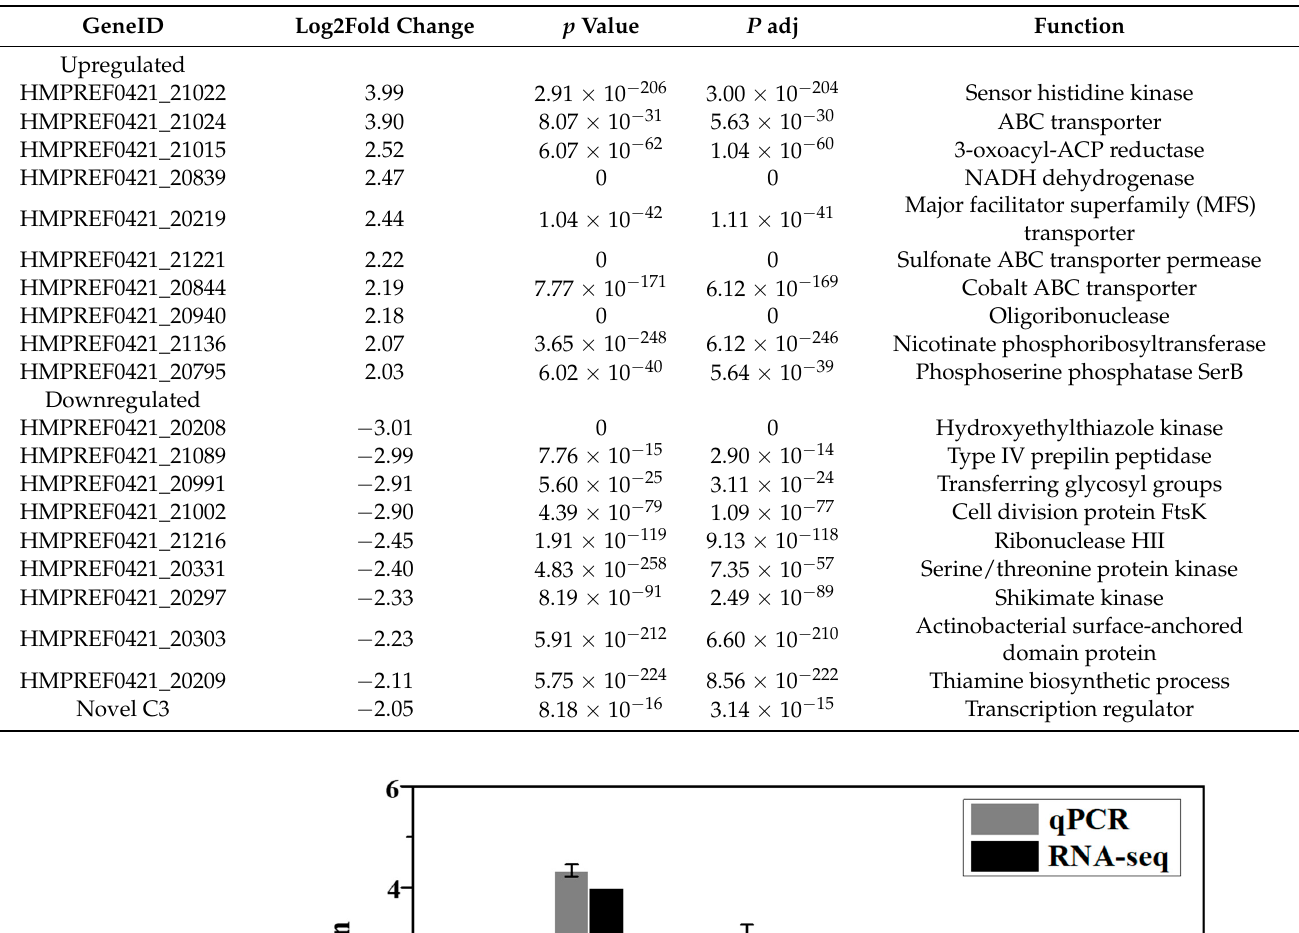
Table 1. List of the 10 genes with the highest fold change values among the differentially expressed genes in G. vaginalis cultured under lactate and hydrogen peroxide. All p values were less than 0.02.